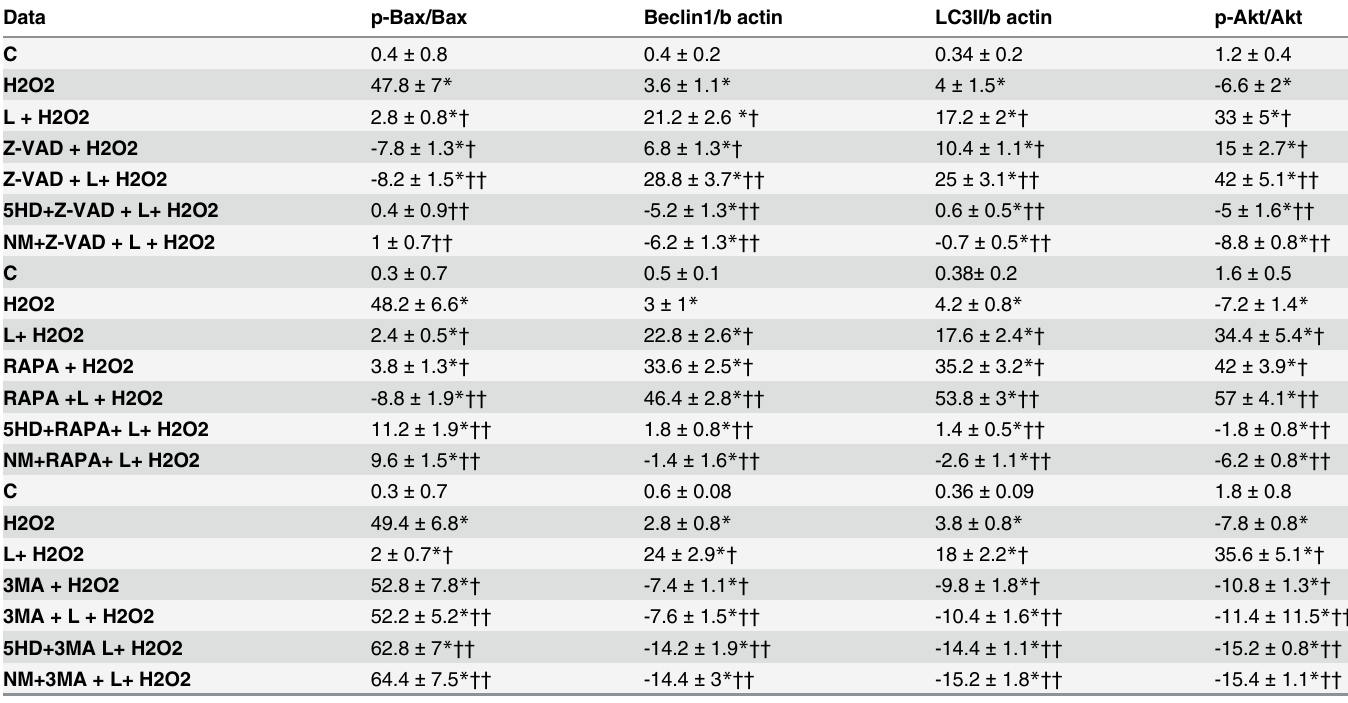
Data are means (%) ± SD of 5 independent experiments. C: control; L = levosimendan (1 μ M); Z-VAD = Benzyloxycarbonyl-Val-Ala-Asp